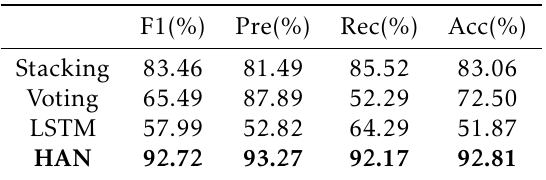
Table 2. Comparative experimental results with other